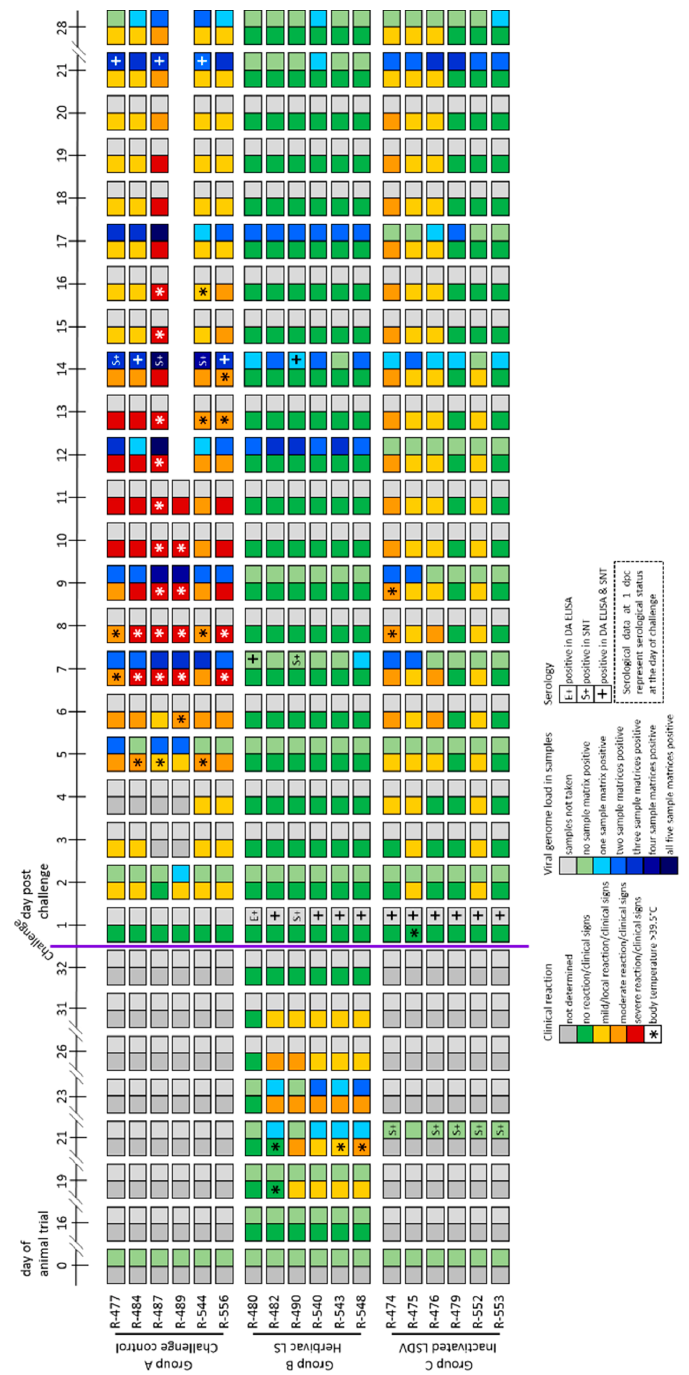
Figure 4. Summarized presentation of adverse reactions after immunization, clinical reaction, viral genome load in different samples matrices and serological examination of the proof-of-concept-study. Adverse reactions are shown at representative days post vaccination. Furthermore, strength of clinical reaction and rise in body temperature after immunization or challenge infection are presented (left squares of each day) for each animal. Additionally, extend of viremia and shedding of viral genome as well as serological data (right squares of each day) following challenge infection are shown for each